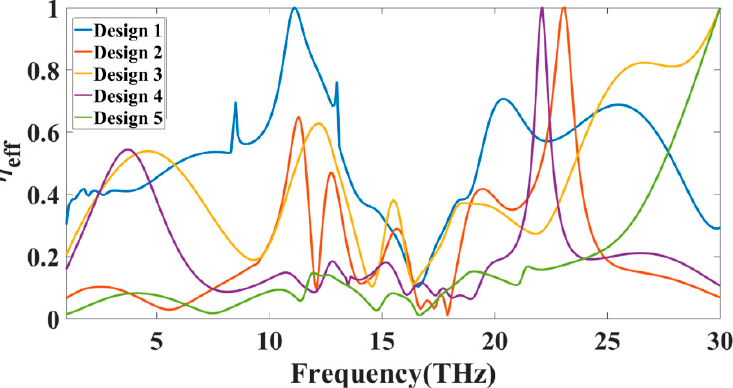
Figure 14. Calculated (simulated results) antenna efficiency for all the antenna structures for 1 to 30 THz of the frequency.